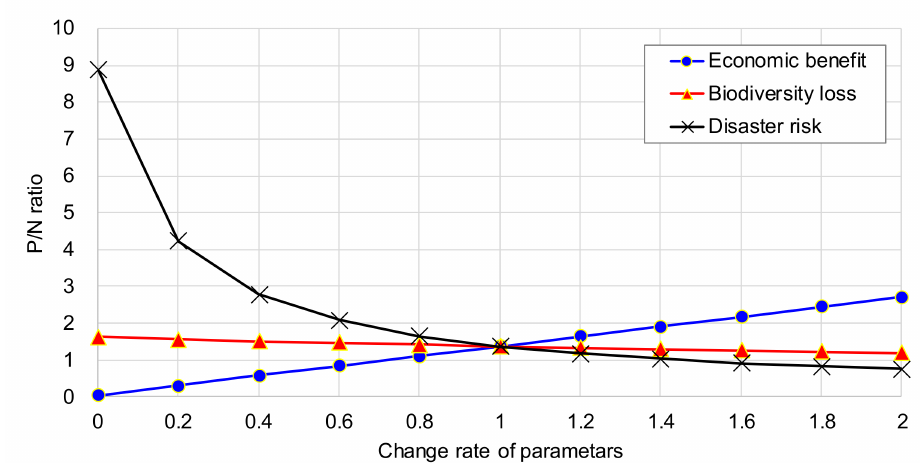
Figure 11. Sensitivity